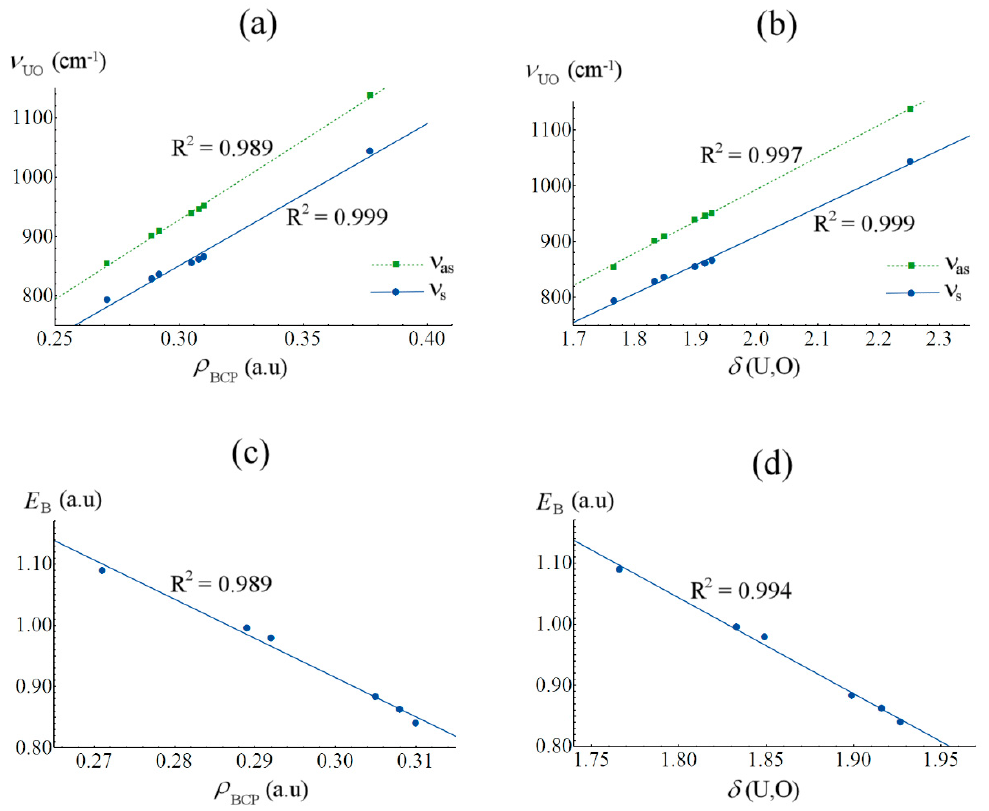
Figure 6. Correlation between QTAIM parameters of the U–O bond, U–O stretching vibrational frequencies, and the binding energy of the equatorial ligand set in [UO 2 X 2 Y 2 ] 2 − complexes. ( a ) correlates ν UO and ρ BCP , ( b ) correlates ν UO and δ ( U,O ) , ( c ) correlates E B and ρ BCP , ( d ) correlates E B and δ ( U,O )